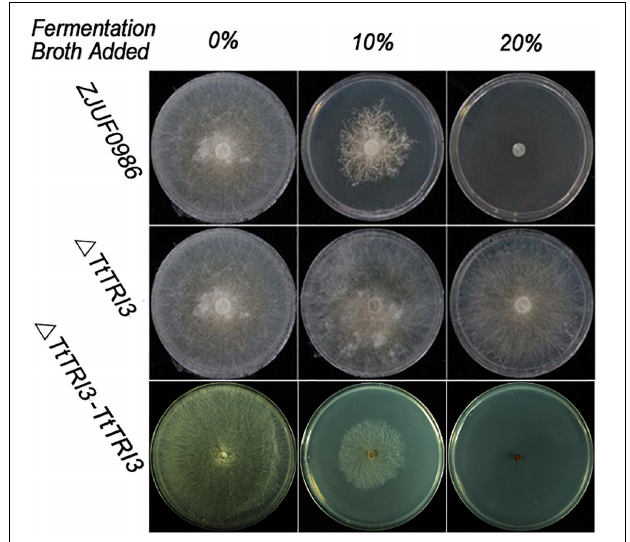
FIGURE 4 | Disruption of TRI3 relieved growth inhibition to Rhizoctonia solani . From left to right: 0% (v/v), 10% (v/v), or 20% (v/v) of harvested fermentation broth from wild-type strain or TtTRI3 disruption strain, or complementation strain was added in potato dextrose agar (PDA). Photos were taken 3 days after